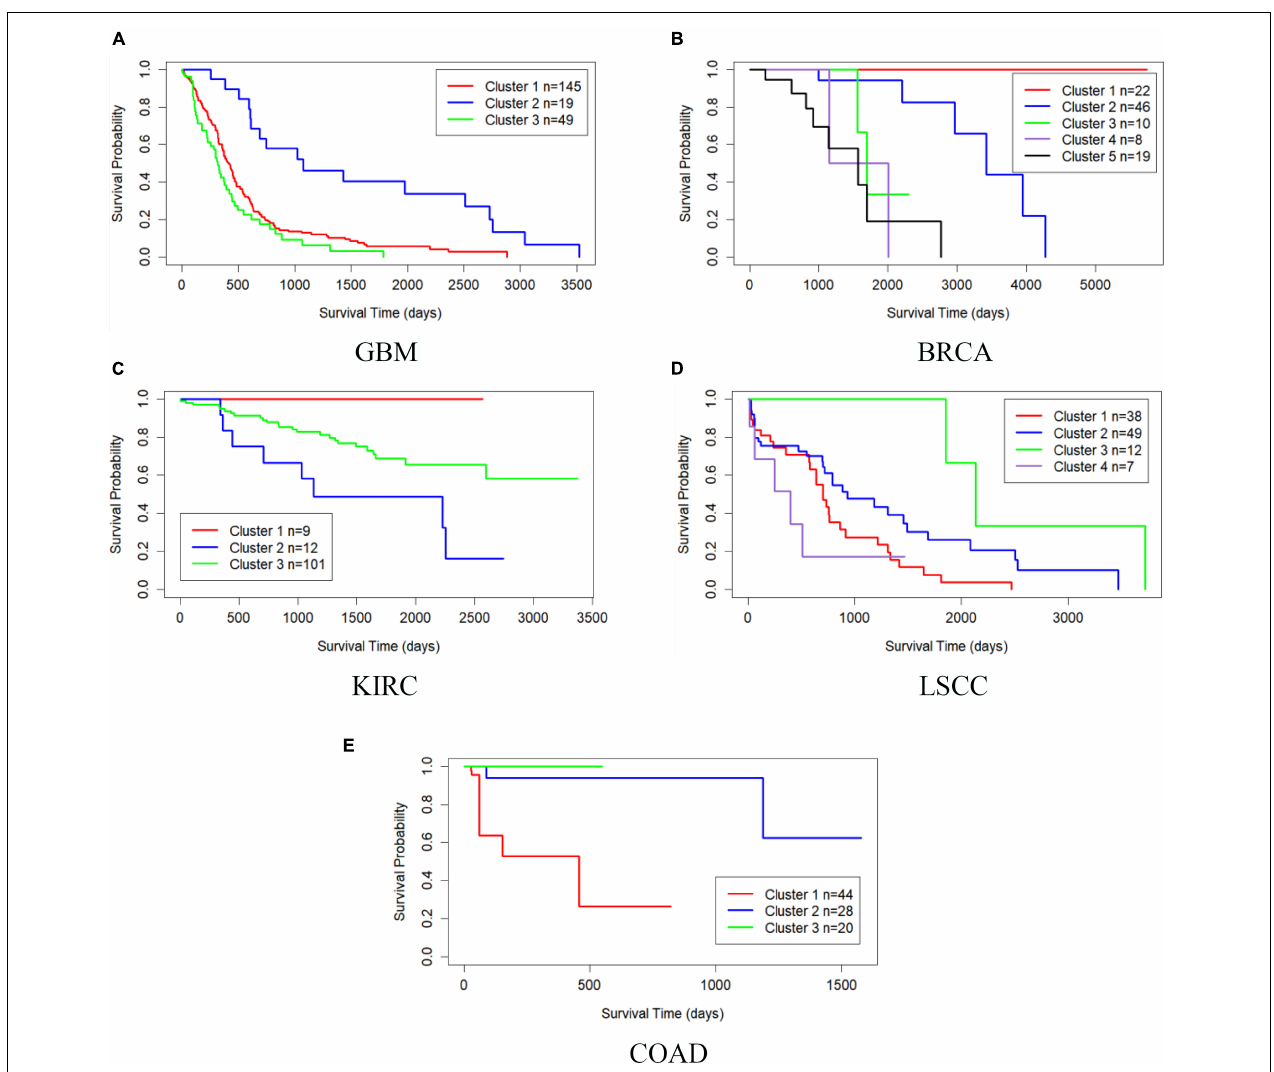
FIGURE 2 | Kaplan–Meier survival curves of MRF-MSC on the cancer types in Wang et al. (2014). (A) GBM, (B) BRCA, (C) KIRC, (D) LSCC, and (E) COAD.